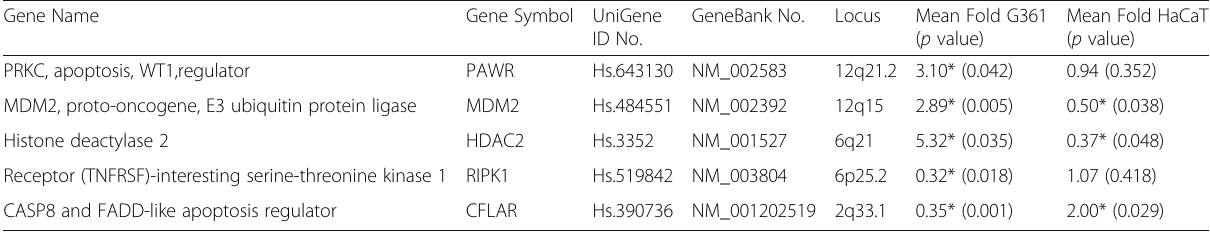
Table 1 ROS and apoptosis related genes those differently regulated by ARE in G361 and HaCaT